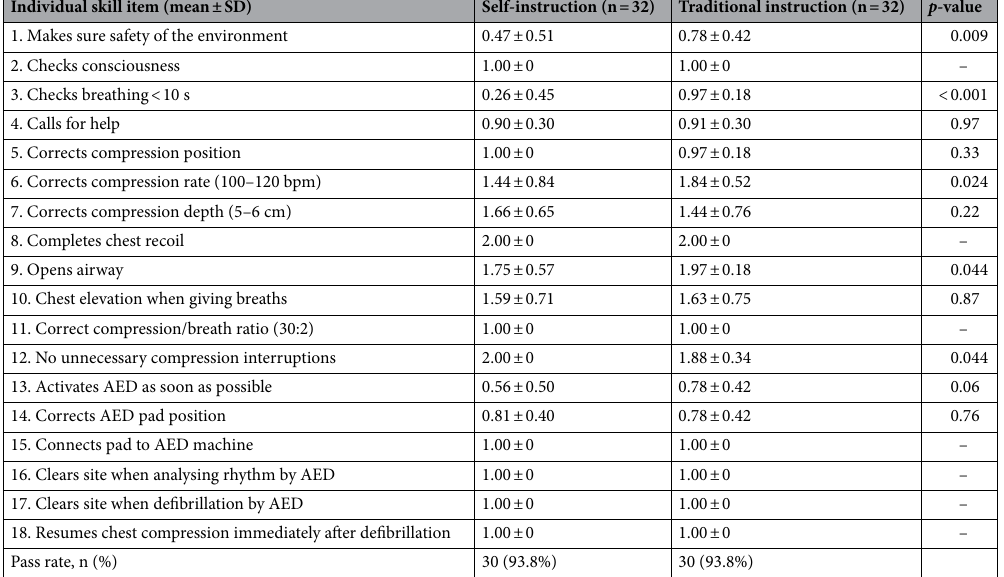
Table 2. Scores of individual skill performance evaluated by evaluators with the checklist. SD, standard deviation; bpm, beats per minute; AED, automated external defibrillator.